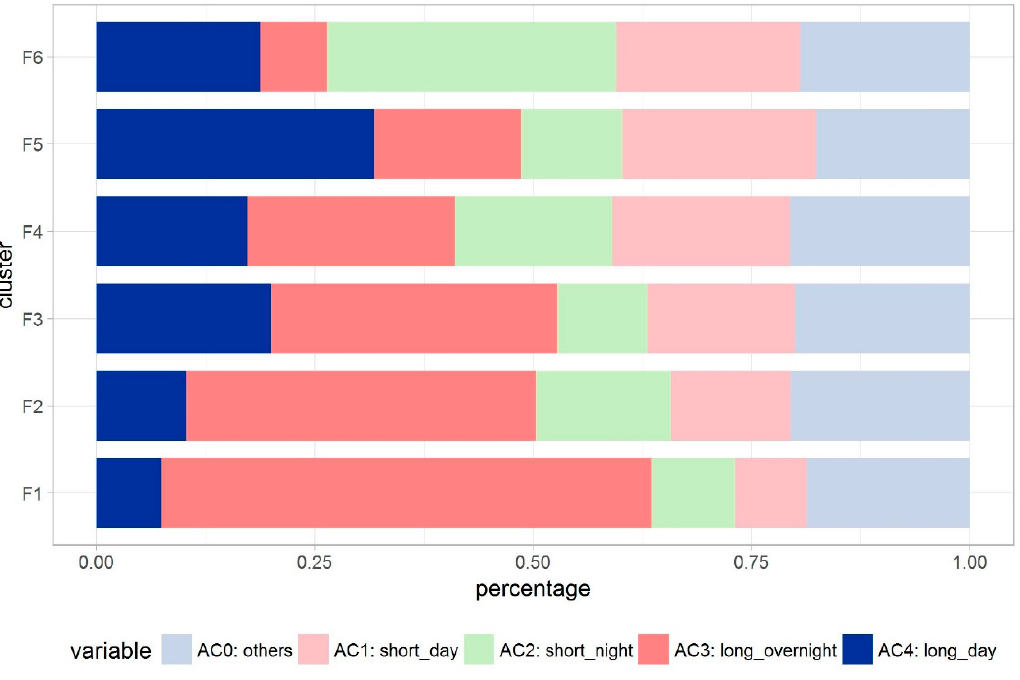
Figure 6. Clustering patterns of different staying activity percentage. Table 3. The average percentage of land use types in the station area of each function cluster. Clusters